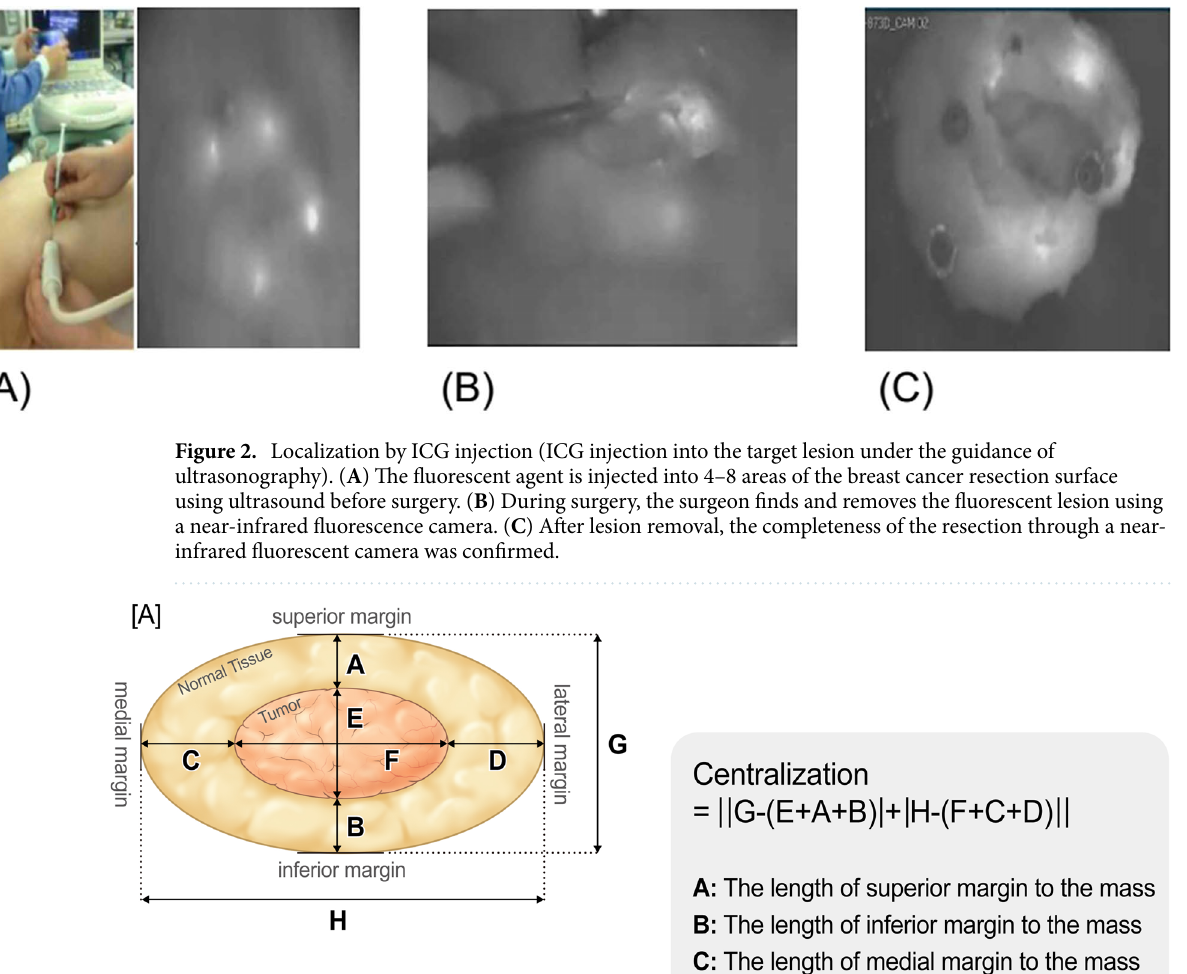
Statistical significance was set at p < 0.05 for all analyses. All statistical analyses were performed using SAS, version 9.4 (SAS Institute Inc., Cary, NC, USA).